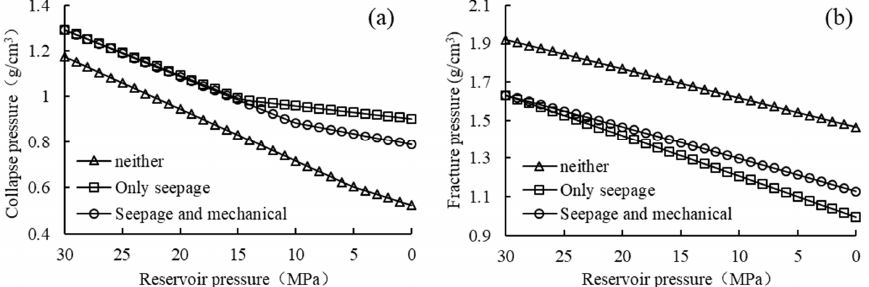
Figure 8. Reservoir fracture pressure change in contrast with different models. ( a ): Collapse pressure evolution with different branch adjustment wells; ( b ): fracture pressure evolution with different branch adjustment wells.